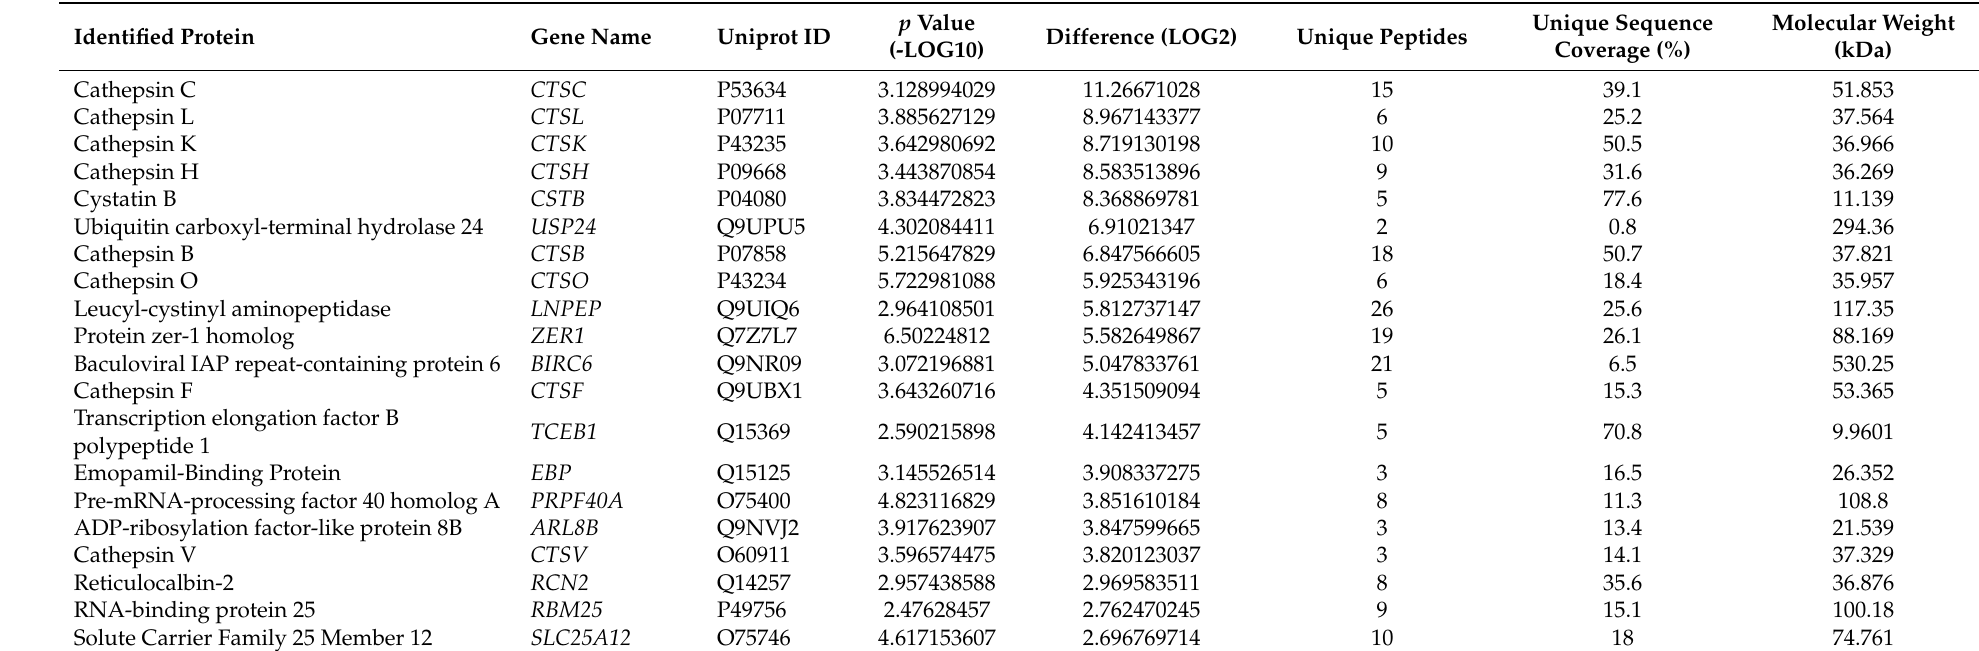
Table 1. Proteins pulled down by WT cystatin C.